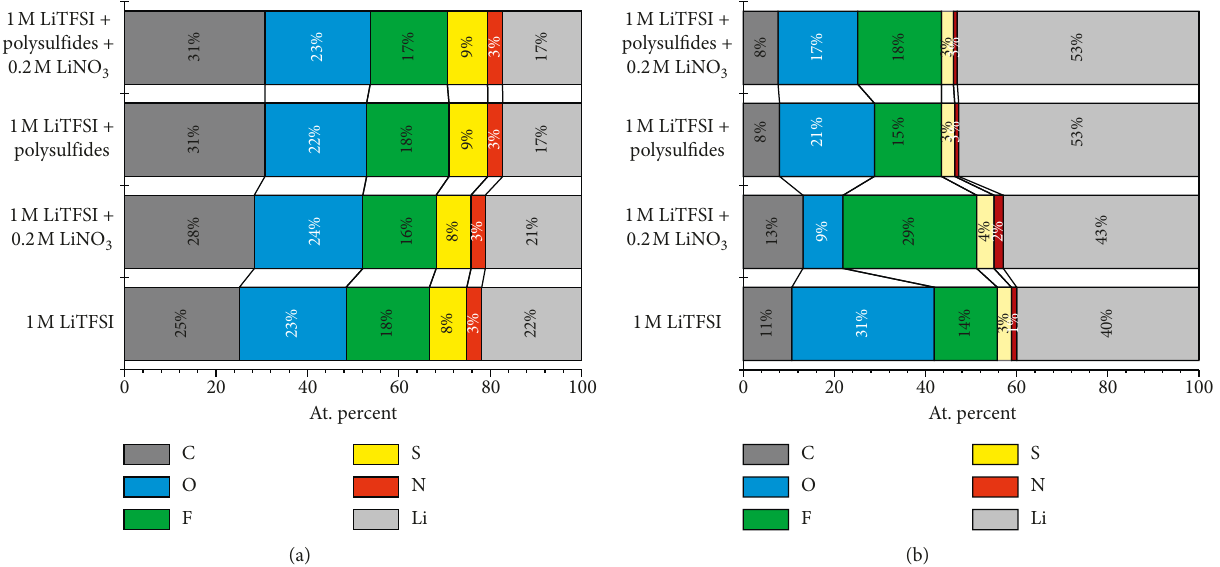
Figure 4: Calculated relative quantities of the elemental composition for spontaneously formed SEI layers in four different electrolytes: before (a) and after (b) 30min sputtering with Ar +